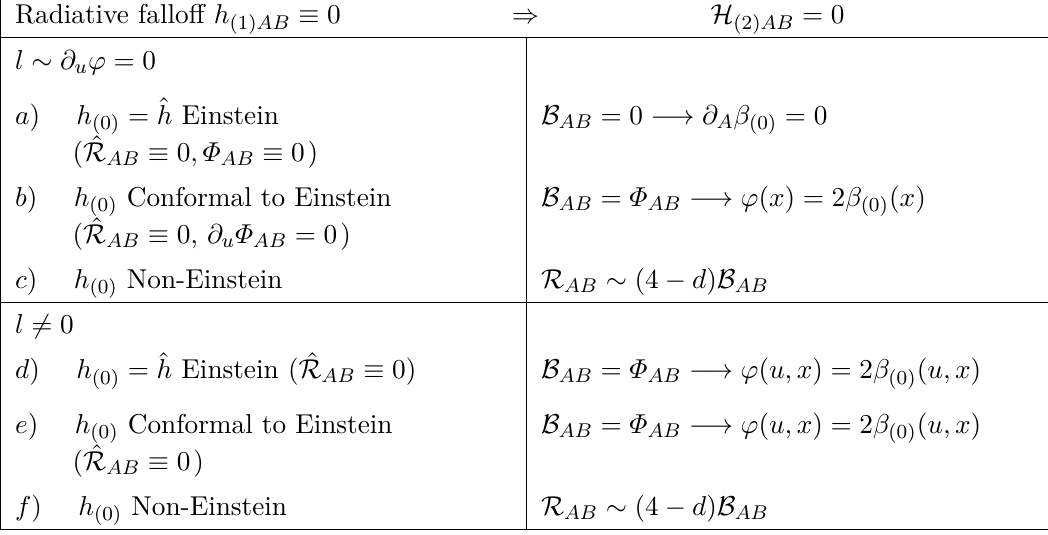
) by the , β (0) AB (0) under (2) AB